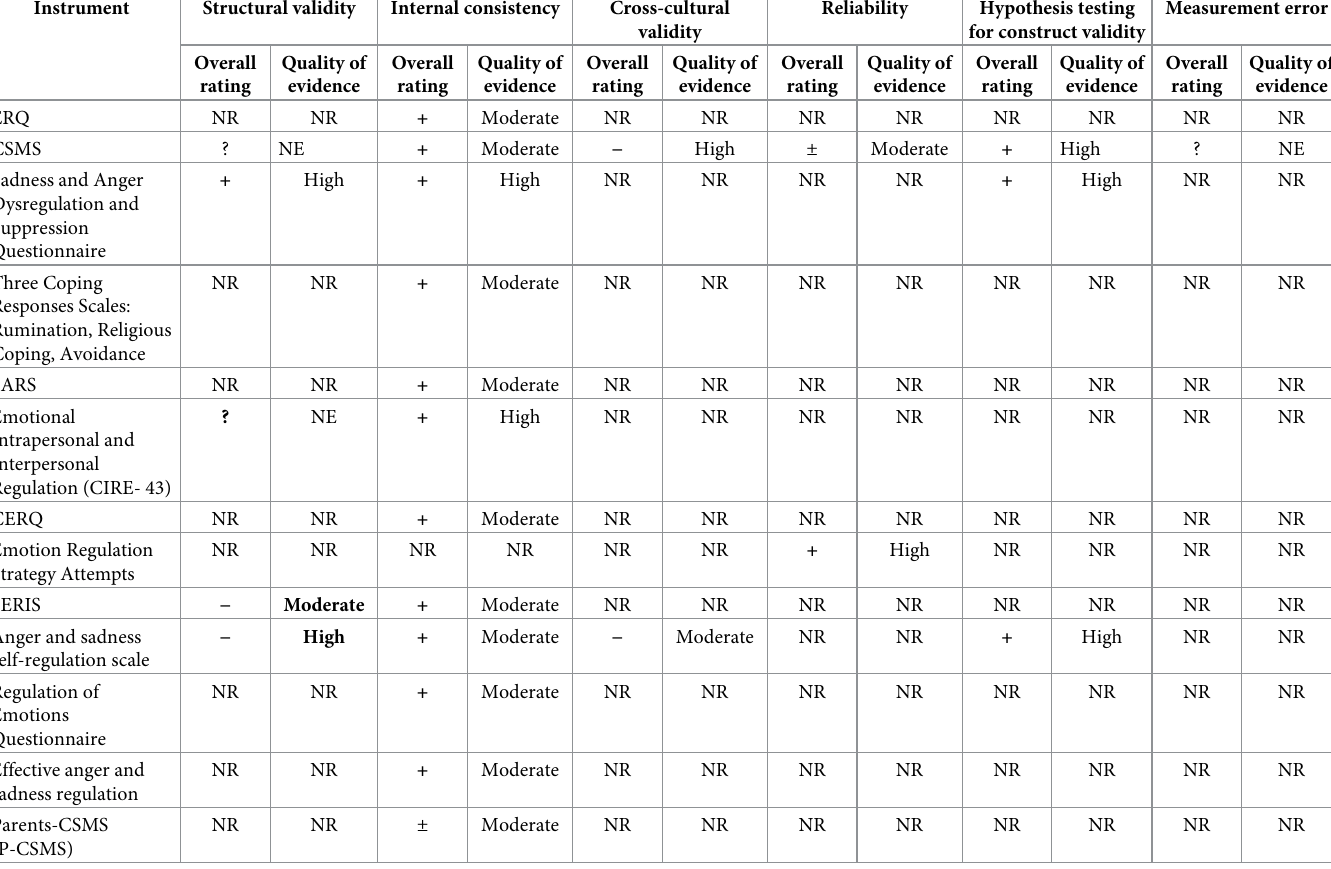
Table 5. Overall quality of psychometric properties and evidence quality per